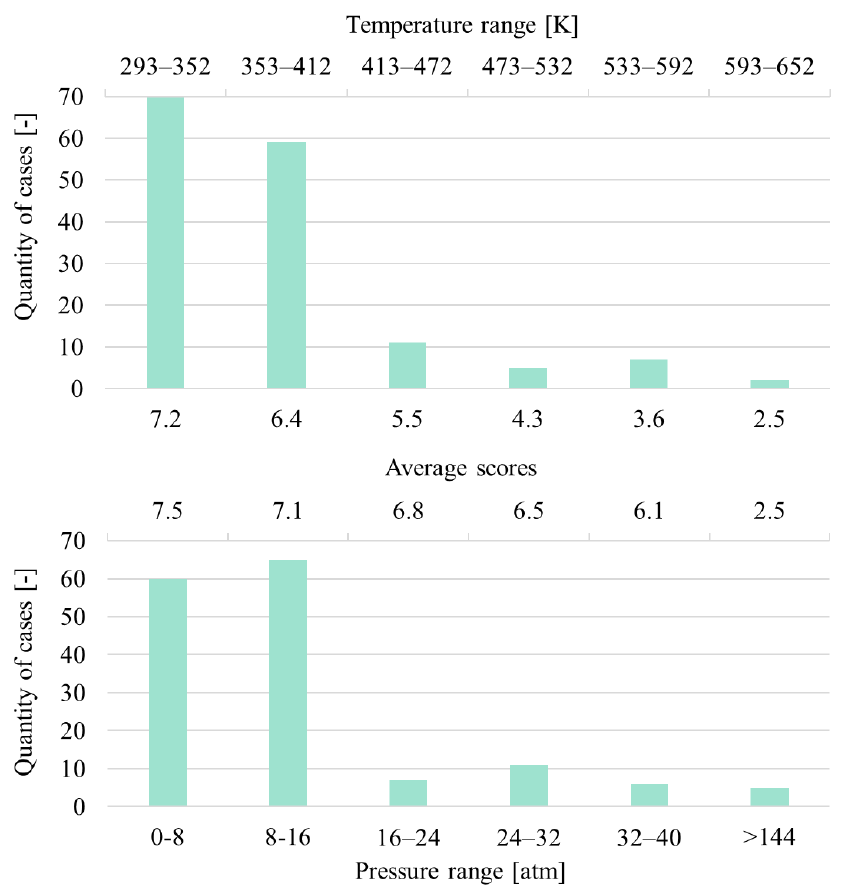
Figure 8. Availability of catalyst performance data on a box and whisker chart: maximum conversion, aniline yield, and selectivity data in percentage ( left ), TON [–] ( right ). On each box plot, the central black line indicates the median, and the solid part of the column shows the first quartile, and the striped part shows the third quartile.